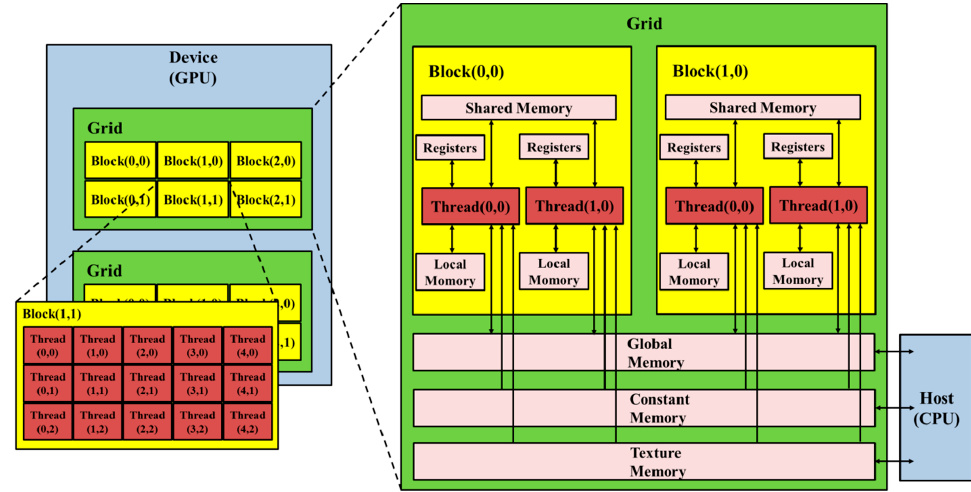
Figure 1. Schematic of CUDA memory hierarchy in GPU.